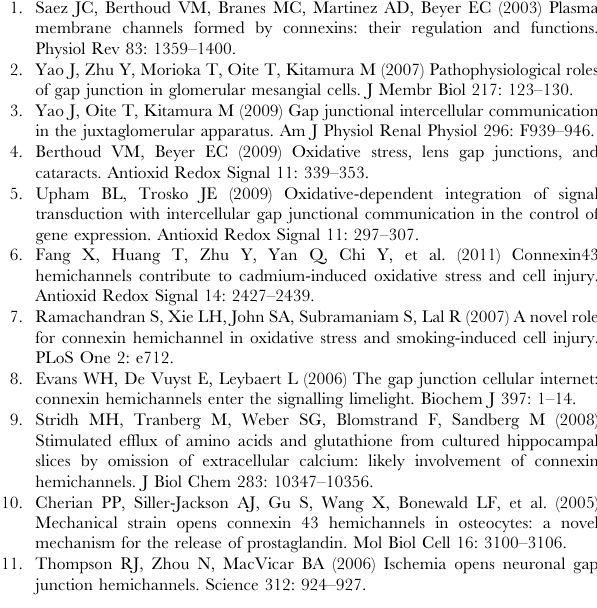
Figure S2 Immunofluorescent staining of Cx43 in Cx43- EGFP LLC-PK1 cells. Cx43-EGFP cells were exposed to 35 m M CdCl 2 for the indicated time and stained for Cx43 (red) and DAPI (nuclei; blue). Immuofluorescent images of EGFP (green), Cx43 (red) and nuclei (blue) were captured using a CCD camera attached to the IF microscope. The merged images of Cx43 and EGFP (yellow) are shown in the right panel. Note the complete overlapping of Cx43 and EGFP (yellow) and the increased intensity of perinuclear Cx43 following Cd 2 + stimula- tion. (TIF) Figure S3 Effect of Cx43 mimetic peptides on calcium deprivation-triggered release of ATP and GSH in Cx43- LLC-PK1 cells. Cx43-LLC-PK1 cells were pretreated with Cx mimetic peptides Gap20 and Gap26 at the concentration of 100 m M for 1 h, and then changed to calcium-free medium containing the same amount of peptides for additional 15 min. ATP (A) and GSH (B) concentration in culture medium was measured. The data were expressed as the fold induction against untreated control (mean 6 S.E., n= 4). # p , 0.01, * p , 0.05 versus Cd 2 + alone, and ** , 0.01 versus untreated control.